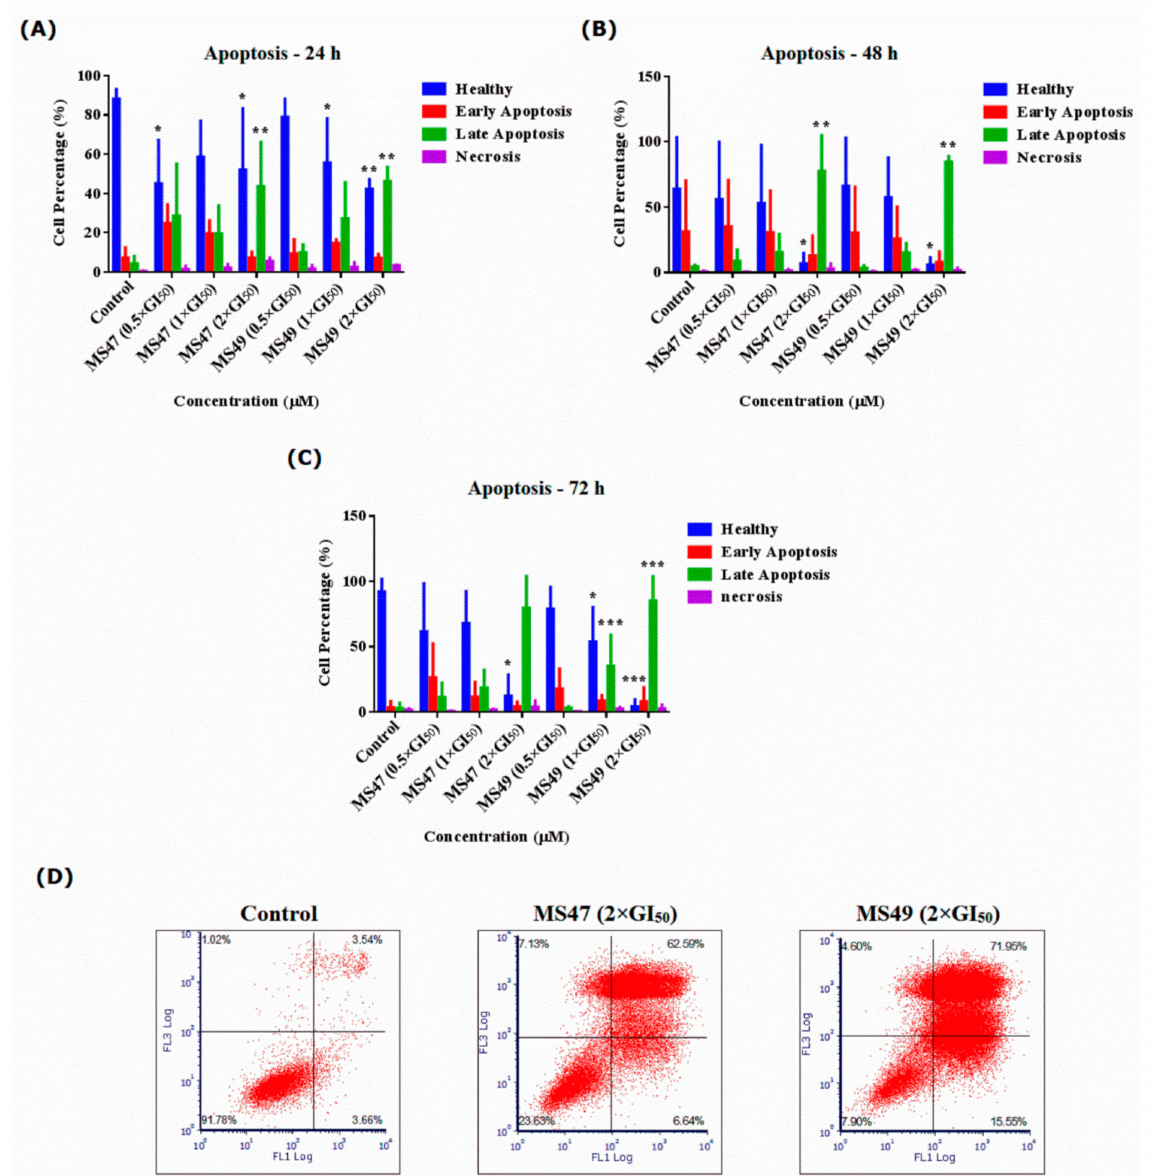
Figure 7. Statistical analysis of the percentages of healthy, apoptotic (early and late) and necrotic human melanoma MDA-MB435 cells, treated with MS47 and MS49 (0.5 × GI 50 , 1 × GI 50 and 2 × GI 50 ) compared to the untreated cells (control group) for ( A ) 24 h, ( B ) 48 h and ( C ) 72 h. Both ligands caused significant increase in the percentage and number of the late apoptotic cells (* p < 0.05, ** p < 0.005, *** p < 0.0005; experiments were repeated ≥ three times, n = 2). ( D ) Flow cytometric analysis (histograms) of cell apoptosis mechanism (apoptosis/necrosis) in human melanoma MDA- MB435 cells, treated with MS47 and MS49 of 2 × GI 50 concentrations compared to the untreated cells (control group) and stained with FITC-conjugated annexin V and propidium iodide (PI) for 72